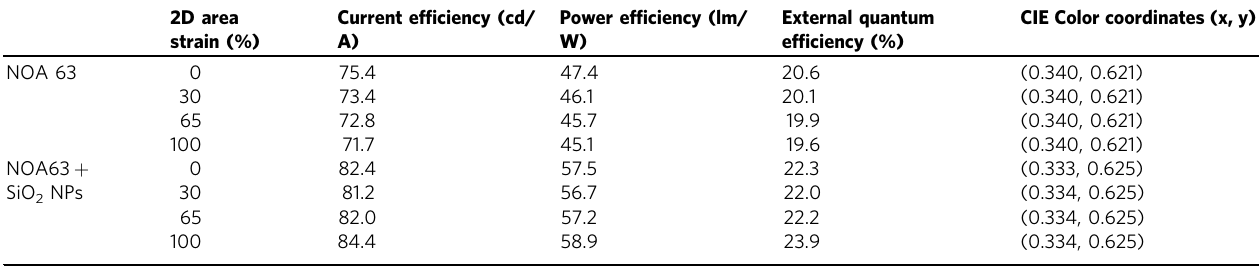
Color coordinates are presented in compliance with International Commission on Illumination